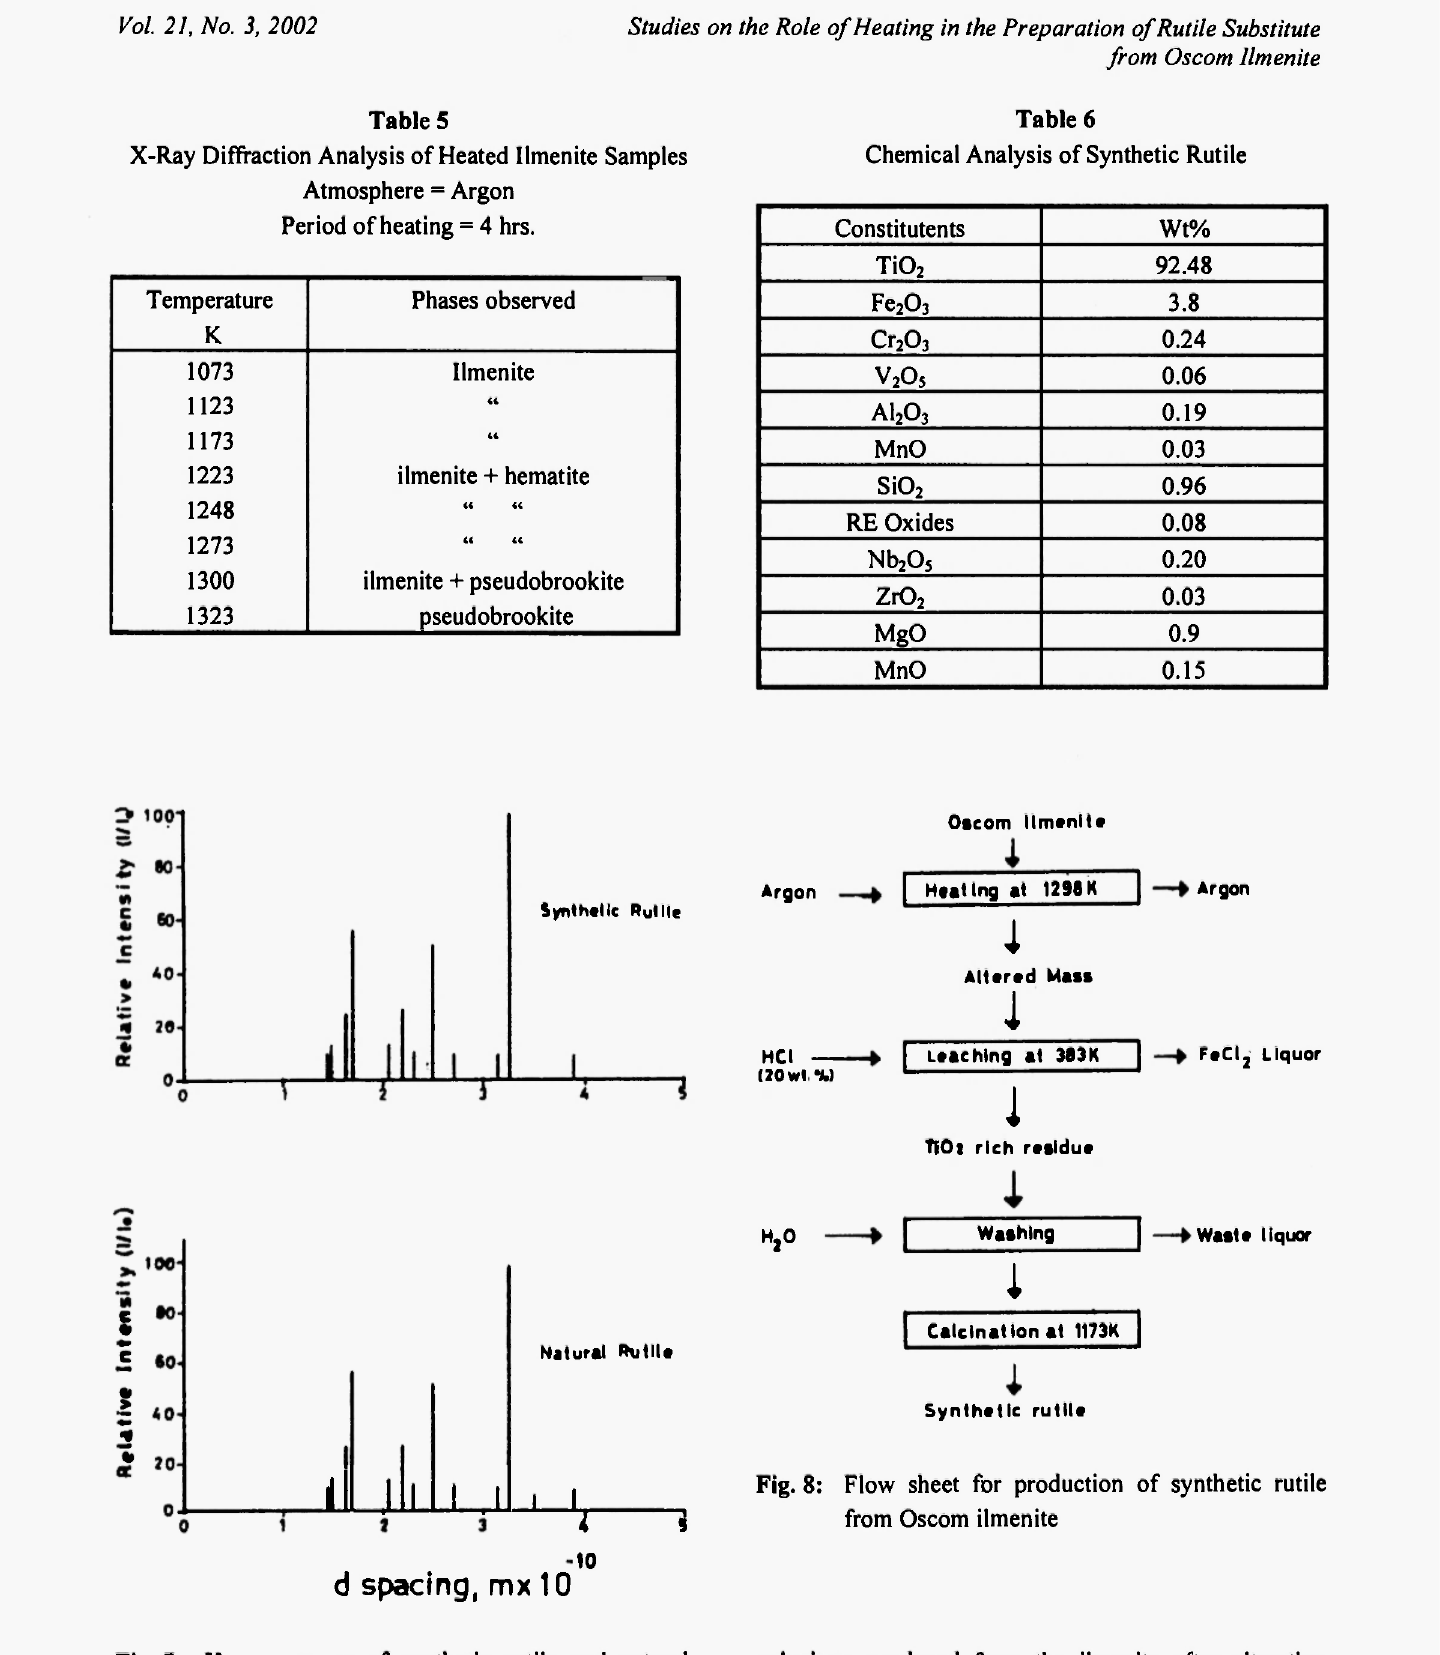
Fig. 7: X-ray patterns of synthetic rutile and natural substitute produced from the ilmenite after alteration rutile and